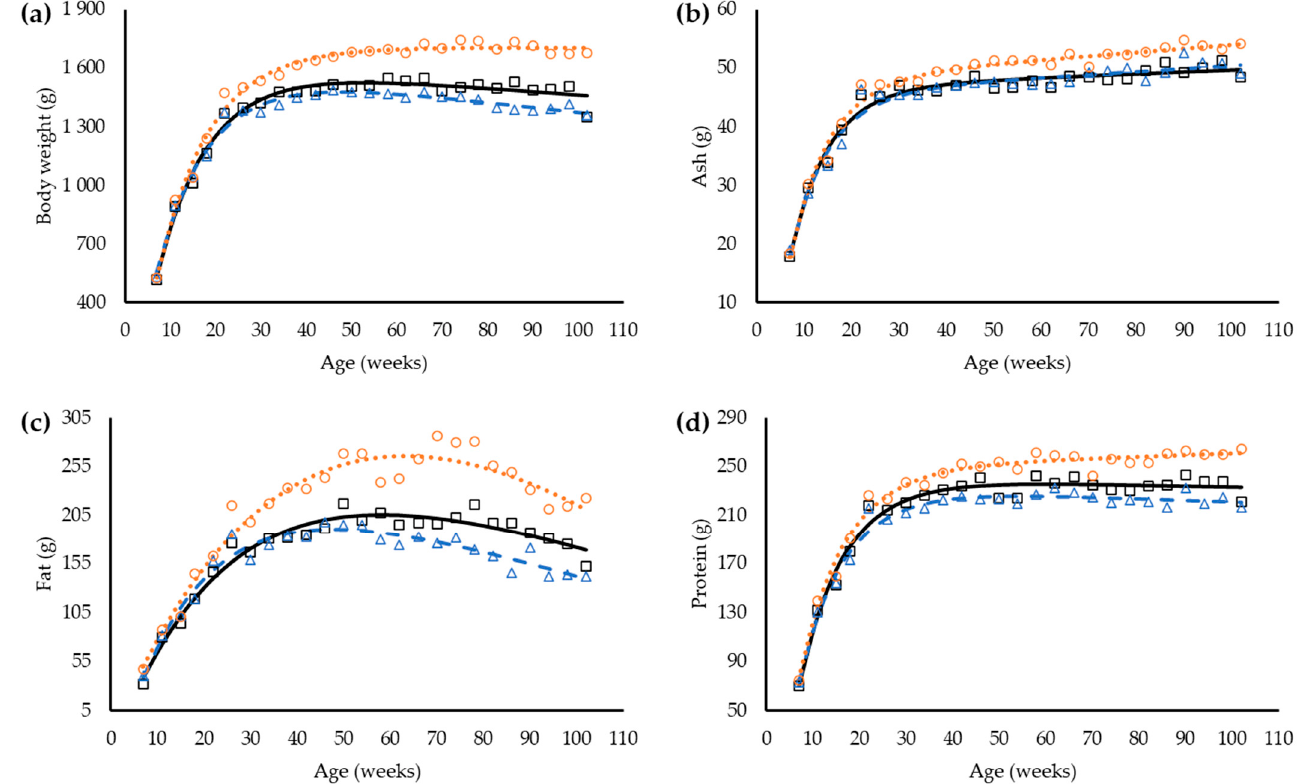
Figure 2. Observed and predicted body weight ( a ) and body components (ash ( b ), fat ( c ), and protein ( d )) of laying hens from 8 to 102 weeks old fed three balanced protein feeds: standard ( □ , —); low ( ∆ , - -) and high ( ○ , ∙∙∙ ).